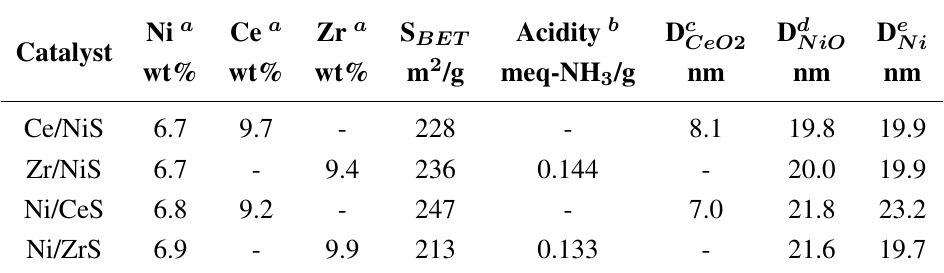
catalysts modified by Ce or Zr. 2